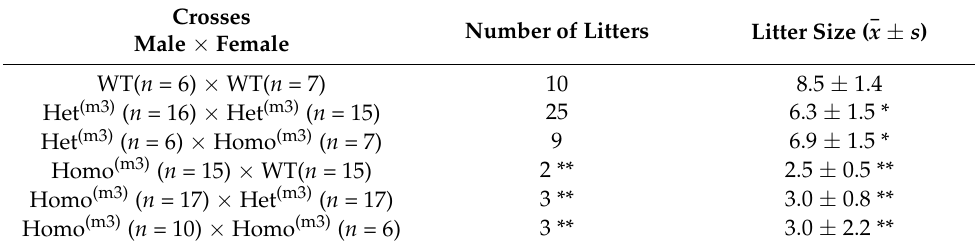
Table 1. Fertility parameters of Plcz1 m3 ( 𝑥 ̅ ± s , * p < 0.05, ** p < 0.01)